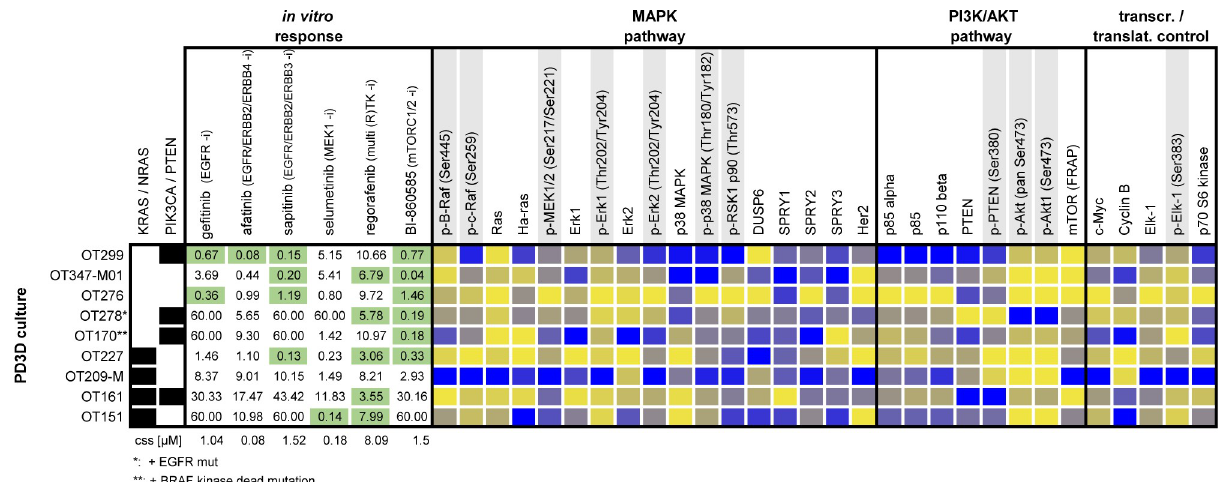
Fig 3. Bead-based western blot analysis of (phospho-)proteins in 9 organoid cultures. DigiWest-based protein expression analysis of 30 (phospho-) proteins in 9 PD3D cultures is shown together with genotype and response data. Samples are sorted according to RAS mutation status. Individual IC 50 values are shown for tested compounds. Green marked IC 50 ’s indicate susceptibility to the respective small molecule. Protein expression values are column-wise color-coded from lowest (yellow) to highest (blue) expression for each analyte. Phosphoproteins are marked in grey.